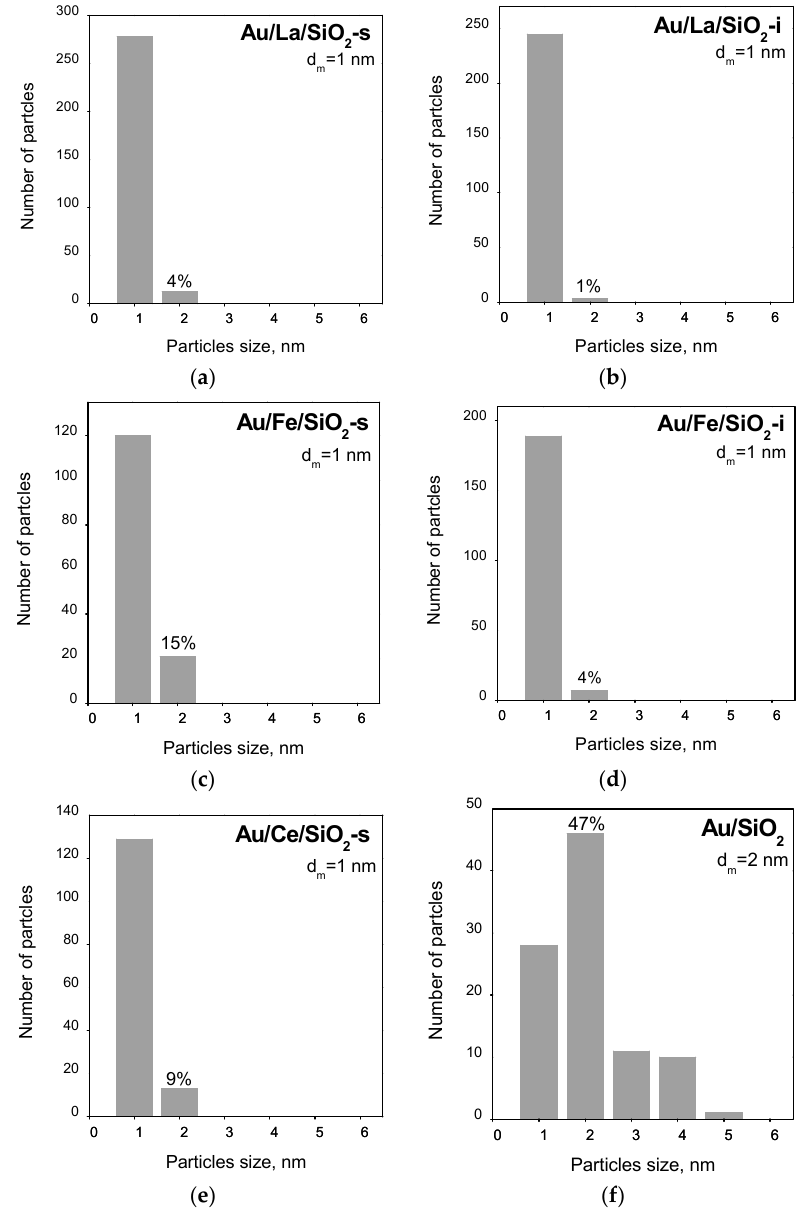
Figure 1. Au particle size distribution obtained by HRTEM: Au/La/SiO 2 -s ( a ); Au/La/SiO 2 -i ( b ); Au/Fe/SiO 2 -s ( c ); Au/Fe/SiO 2 -i ( d ); Au/Ce/SiO 2 -s ( e ); Au/SiO 2 ( f ).